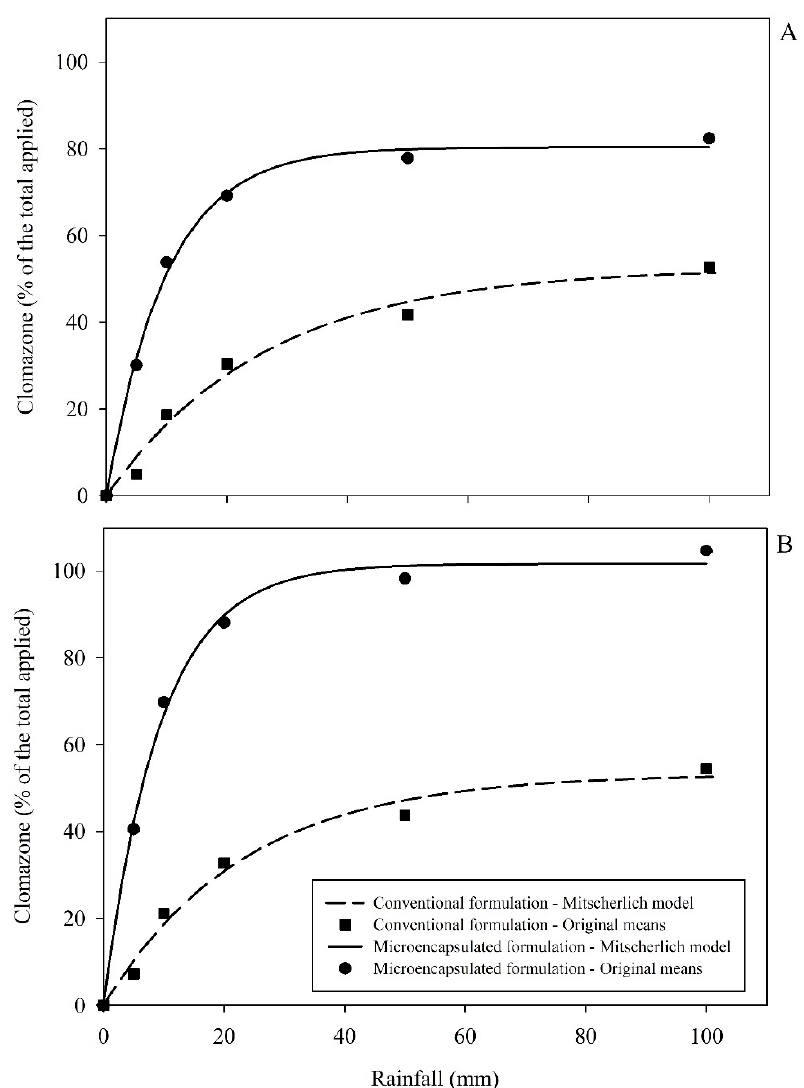
Figure 2. Quantity of clomazone (% of the total applied) percolated through sugarcane straw as a function of different simulated rainfall depths (mm), after application of different formulations. Application of clomazone formulations ( A ); application of clomazone formulations combined with sulfentrazone ( B ).